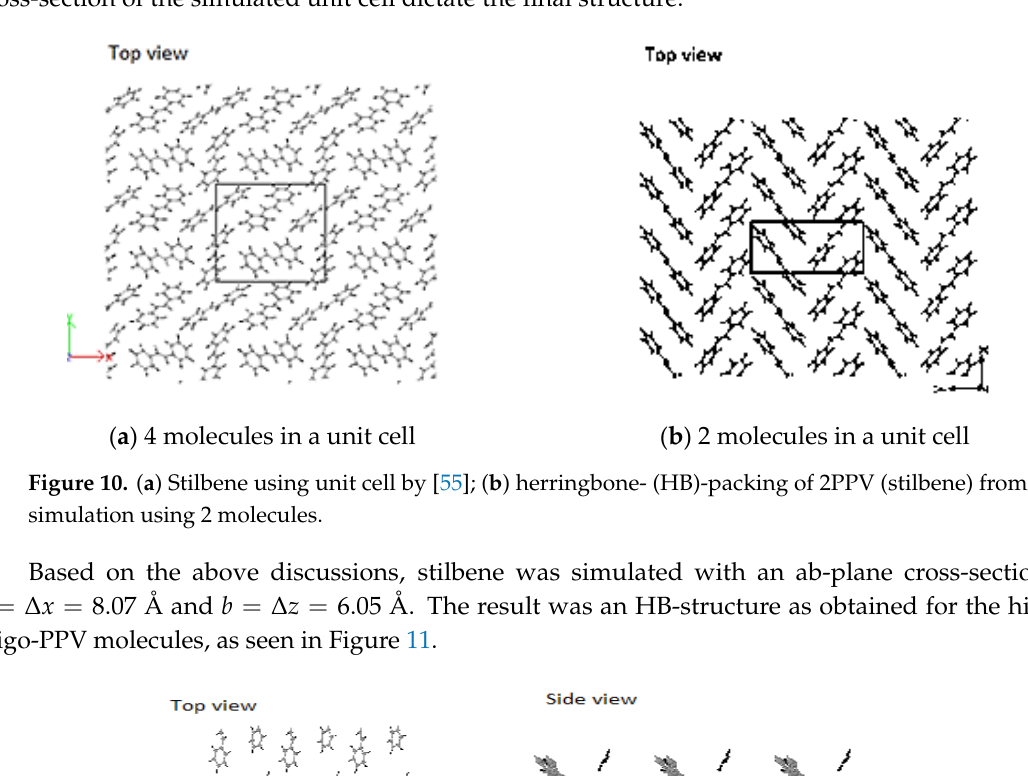
Figure 12. Three-PPV oligomer chains (3PPV) HB-packing from simulation.